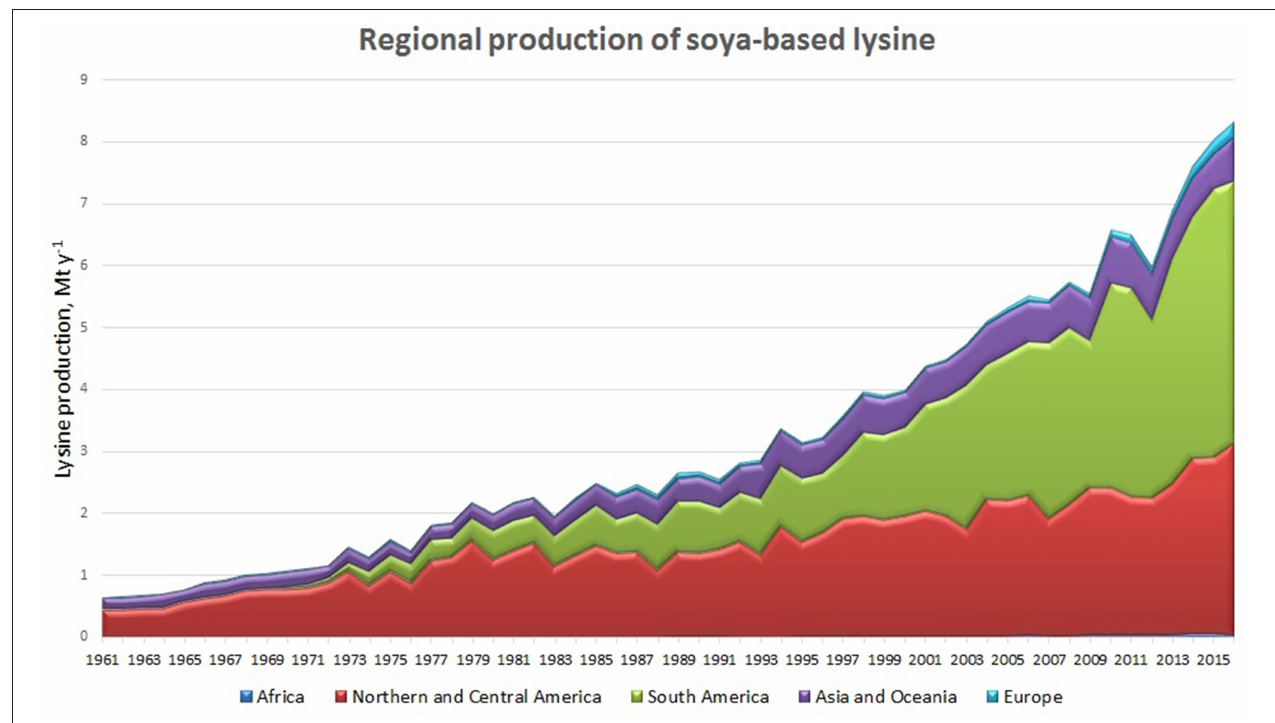
FIGURE 6 | Regional production of soya-based lysine (Mt y − 1 ) between 1961 and 2016. The two dominant areas of current production are South America (predominantly Brazil and Argentina) and North America (predominantly USA).